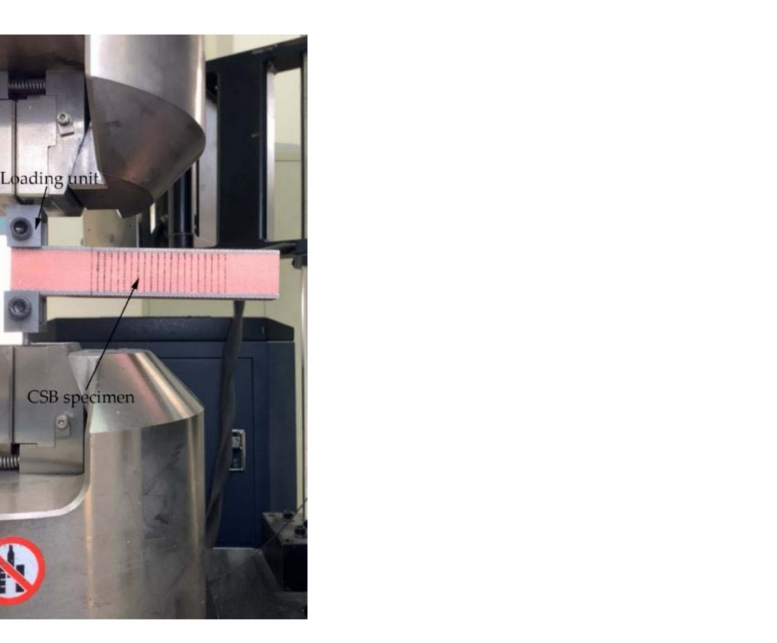
Figure 5. Setup of CSB testing of GFRP/foam sandwich composite specimens.